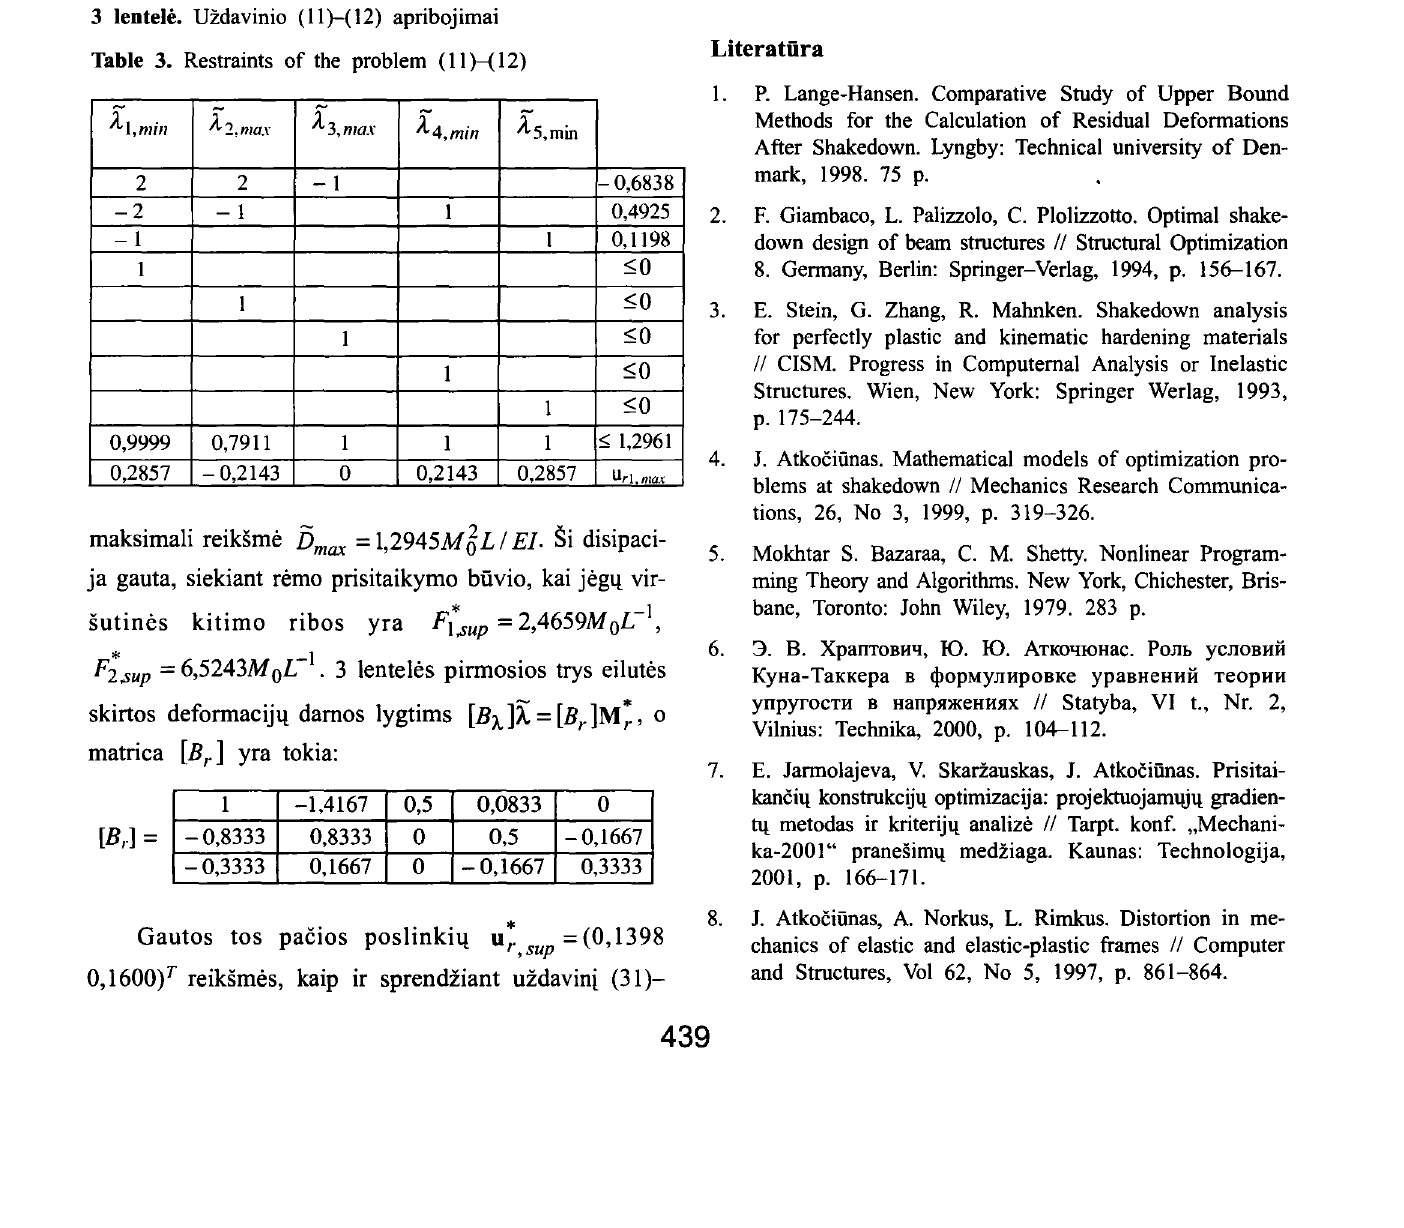
Table 3. Restraints of the problem (II)-{